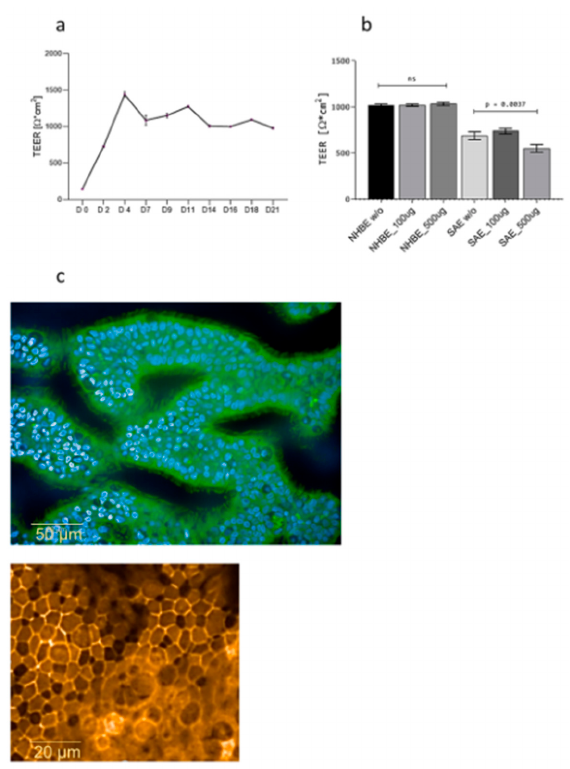
Figure 1. ( a – c ) Dexamethasone does not have an impact on epithelial integrity. ( a ) Transepithelial electrical resistance (TEER) values before dexamethasone treatment. Differentiation of the pseudostratified layer was carried out for 21 days under air–liquid interphase (ALI). Values were retained at >400 Ohms.cm 2 from Day 2 with fluctuations then stabilization at Day 14 (1089.33 ± 46.36 Ω * cm 2 ), indicating intact membrane integrity. ( b ) TEER values following 7-day dexamethasone treatment. Differentiation of the pseudostratified layer was carried out for 21 days under ALI. After differentiation was complete, primary normal human bronchial epithelial NHBE cells, as well as small airway epithelial (SAE) cells, were treated with 100 µg mL − 1 and 500 µg mL − 1 dexamethasone for 7 days, and epithelial integrity was analyzed using TEER. No differences in the epithelial integrity of NHBE cells were observed. However, SAE was significantly impacted at the higher concentration used. ( c ) Phenotypic analyses of dexamethasone-treated tissues using confocal microscopy. Repre- sentative images depict an intact ciliary structure (upper panel) and tight junctions (lower panel) in 3D epithelia treated with 500 µg/mL dexamethasone. Images were taken using a 40× water objective, staining was done using Hoechst 33,342 (blue) for nuclei, WGA-Alexa Fluor ® 488 (green) for ciliated structures, and Occludin592 (orange) for tight junctions. Scale bar as indicated.